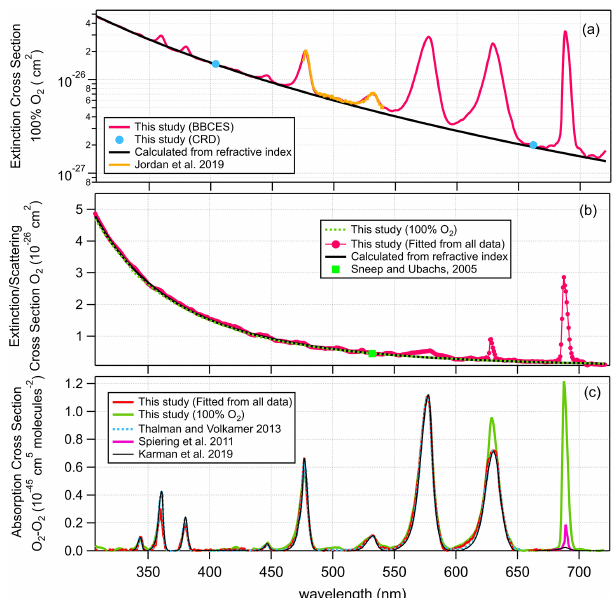
Figure 5. Wavelength-dependent extinction cross sections of 100% O 2 (a) , extinction cross sections of O 2 (b) , and O 2 –O 2 CIA cross section (c) .